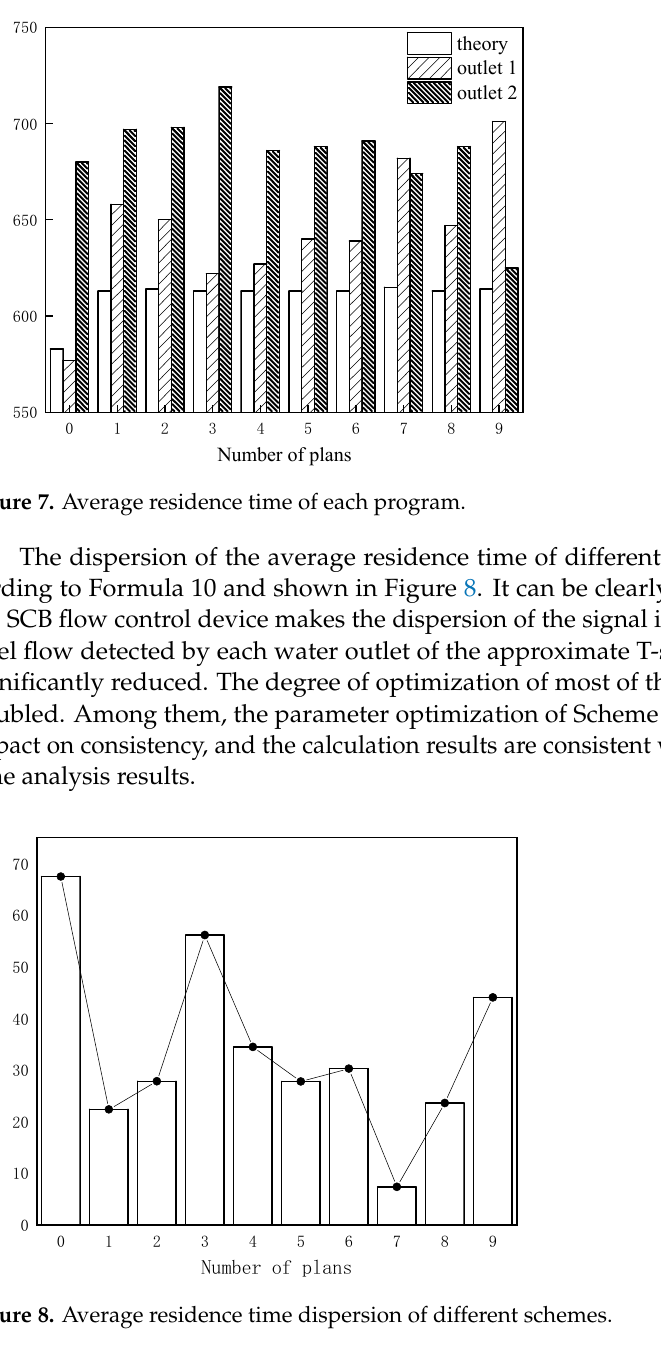
Figure 8. Average residence time dispersion of different schemes.